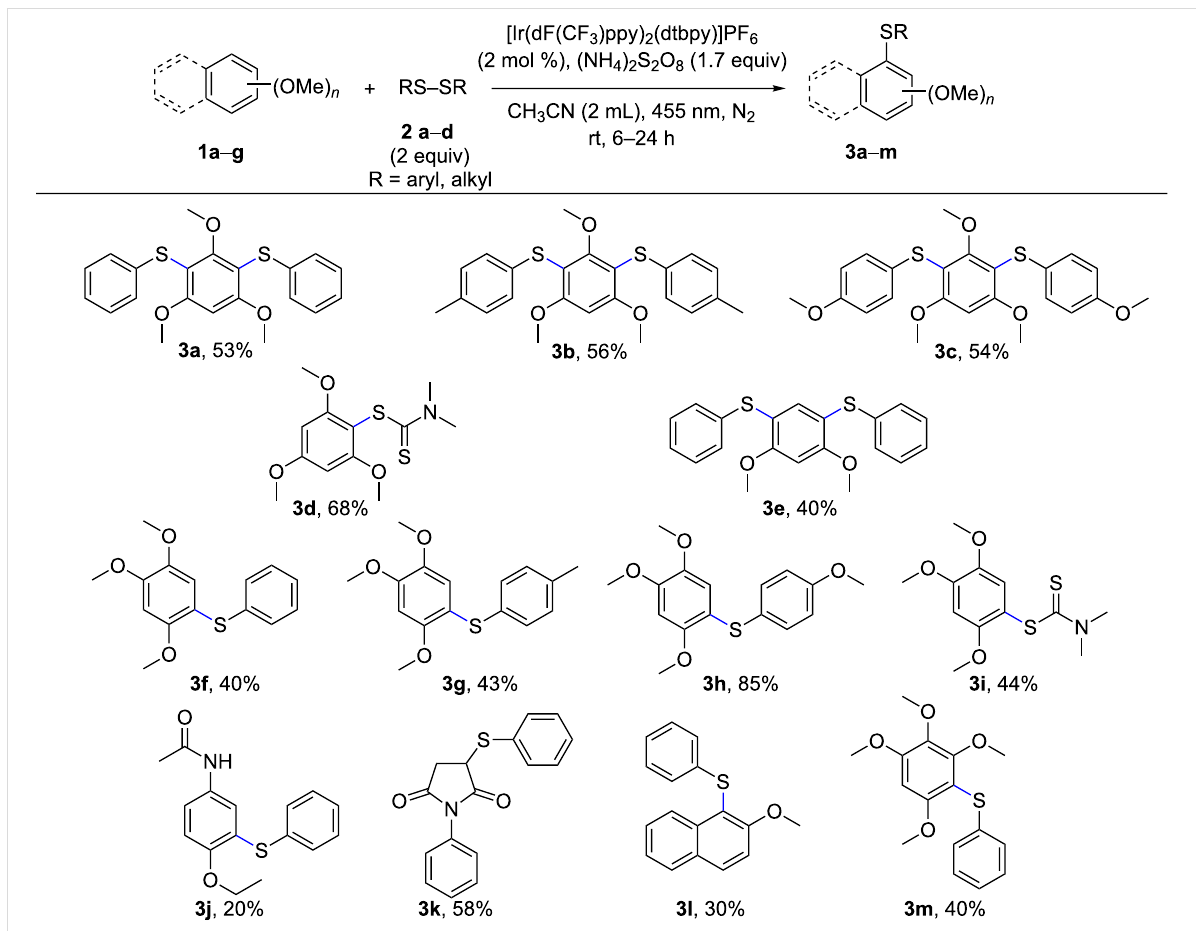
Scheme 3: Substrate scope for arylthiol syntheses. The reaction was performed with 1a – g (0.1 mmol) and 2a – d (2 equiv), (NH 4 ) 2 S 2 O 8 (1.7 equiv) and [Ir(dF(CF